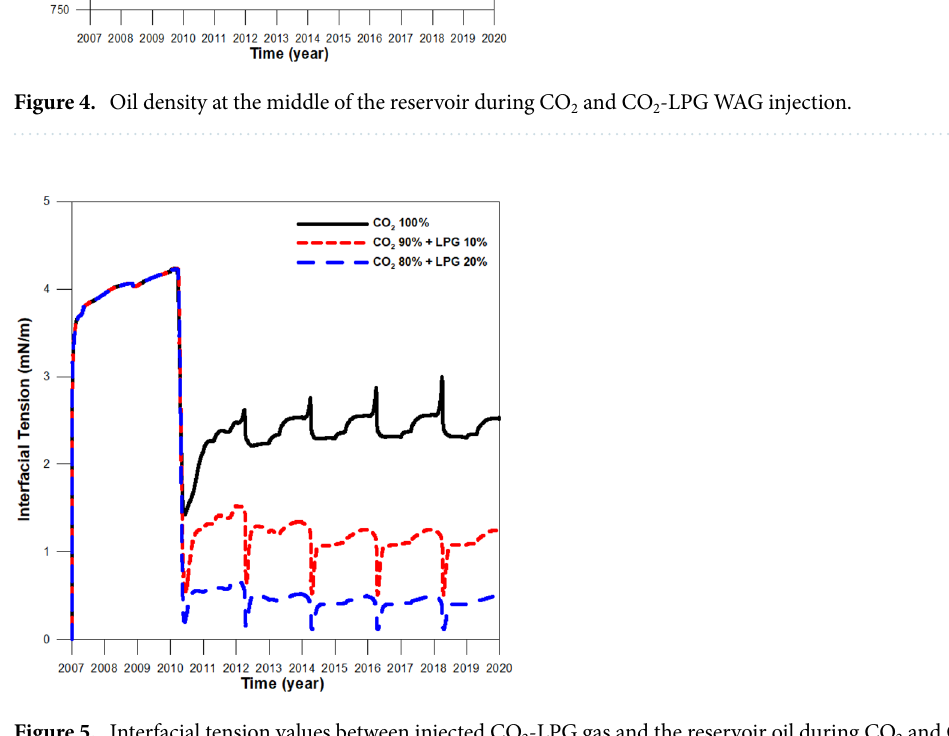
Figure 5. Interfacial tension values between injected CO 2 -LPG gas and the reservoir oil during CO 2 and CO 2 - LPG WAG